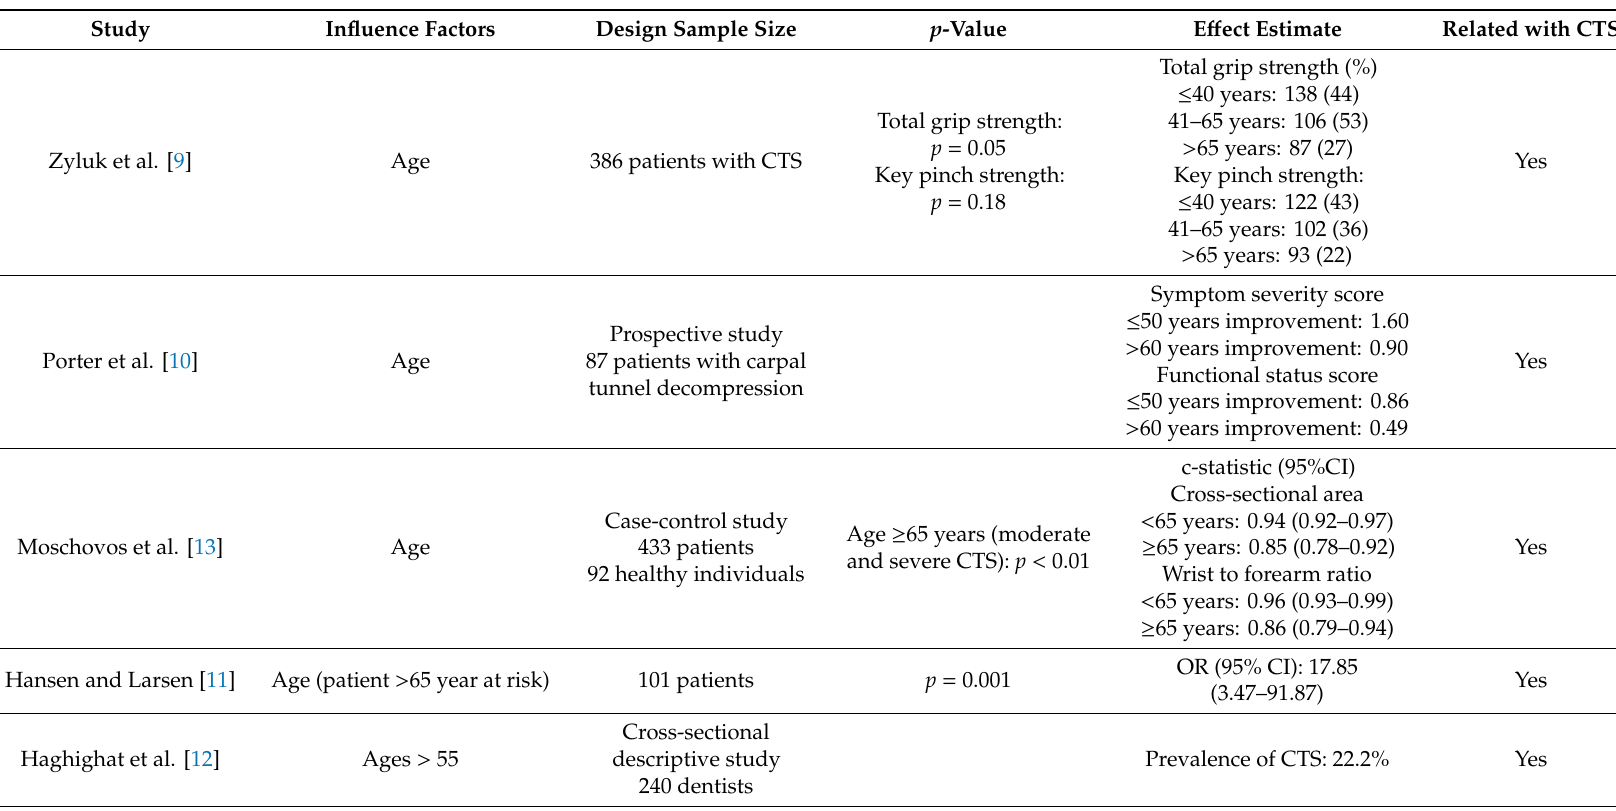
Table 1. Summary of the results obtained from the research reviewed. BMI: Body mass index, PAF: Fraction attributable to the work-related population, SSS: Symptom severity